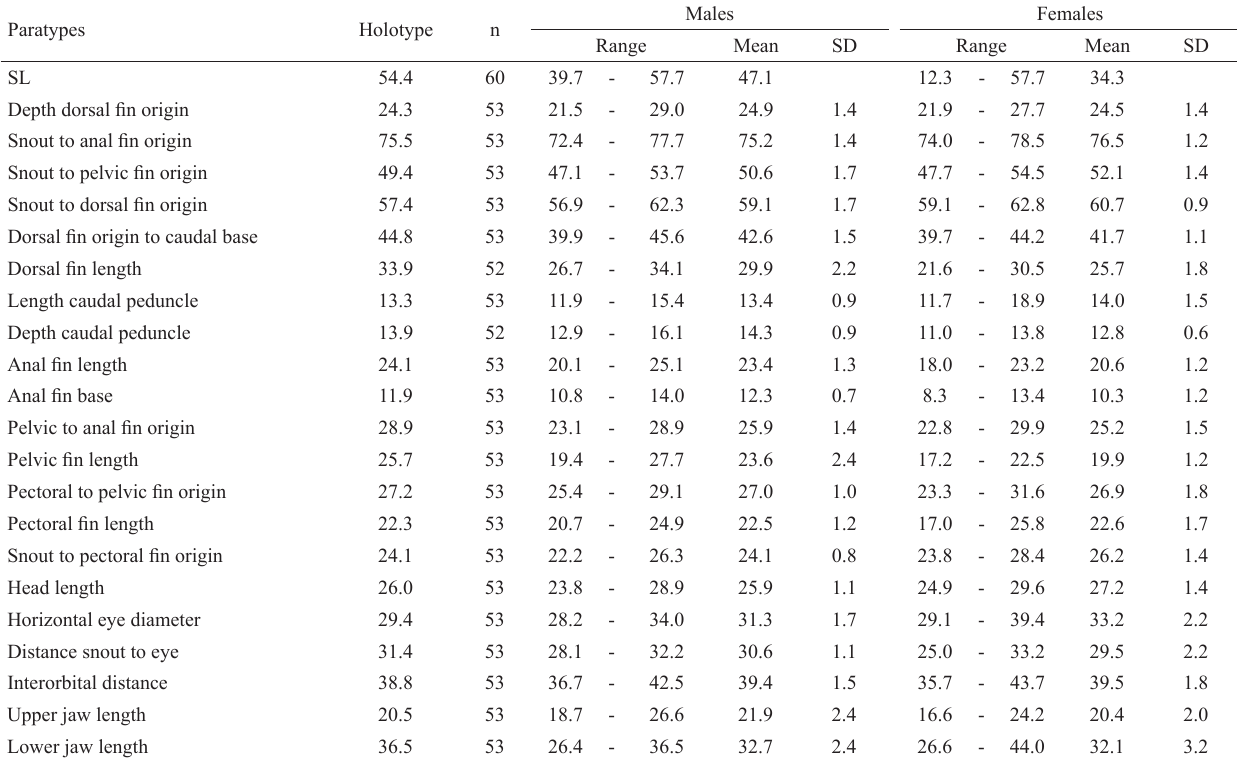
Tab. 1. Morphometric data of the holotype and paratypes of Pyrrhulina capim , new species. SD = Standard Deviation. Paratypes